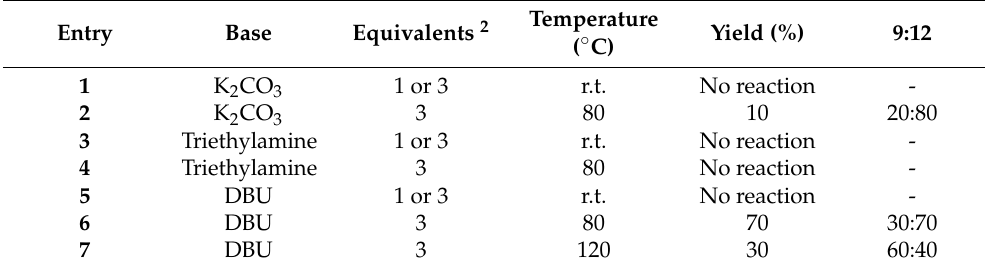
Table 1. Optimization of the reaction between 10 and 11 1 .